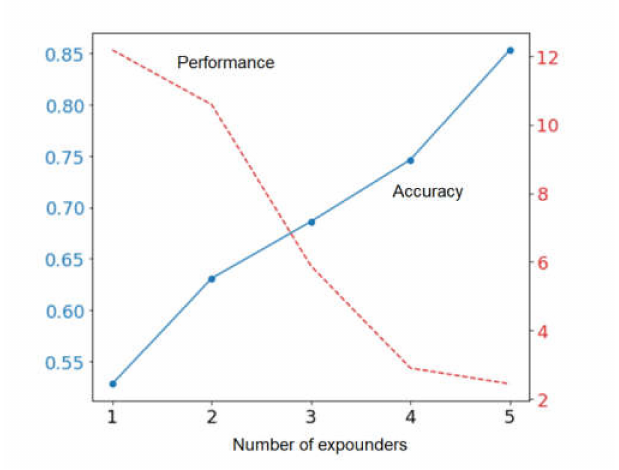
Figure 7. Accuracy versus performance dependency from the number of expounders